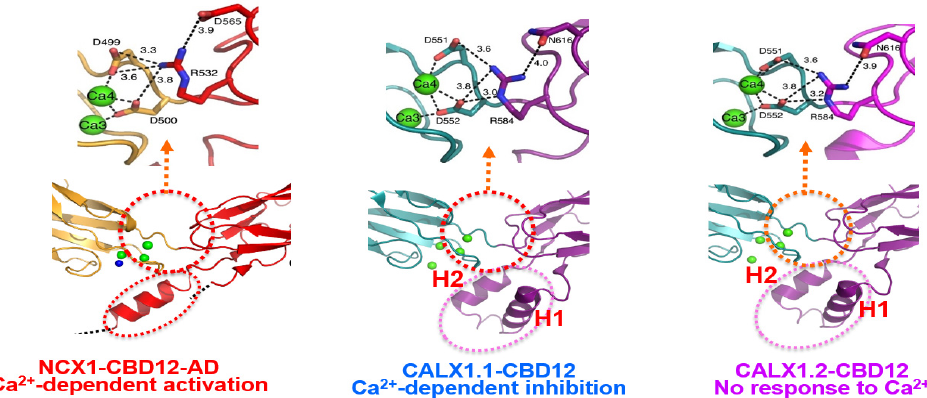
Figure 6. The interface structures of the two-domain CBD12 tandem in the NCX and CALX orthologs. Carton presentation of NCX1-CBD12-AD (PDB 3US9) and CALX1.1-CBD12 (PDB 3RB5) and CALX1.2 (PDB 3RB7) crystal structures depict highly conserved residues participating in the network of interdomain salt bridges. Green balls indicate the Ca 2+ binding sites at the interface of NCX1-CBD12-AD, CALX1.1-CBD12, and CALX1.2-CBD12. The blue ball in NCX1-CBD12 refers to the Ca 2+ binding site that cannot be resolved in the PDB 3US9 crystal structure, although the position of this Ca 2+ binding site is nearly identical to the Ca 2+ binding site of CALX1.1-CBD12 (PDB 3RB5) and CALX1.2 (PDB 3RB7) as revealed by these crystal structures. The Ca 2+ occlusion occurs at the high-affinity binding sites (Ca3-Ca4) of CBD1 in all three proteins (shown in the red-dotted cycle). Although the interdomain salt-bridge structures are highly conserved among NCX and CALX variants, a striking difference between the NCX and CALX variants occurs in the structural organization of the FG-loop α -helix at CBD2. More specifically, the CALX1.1-CBD12 and CALX1.2-CBD12 variants have a two- headed (H1 and H2) short-helix structure, which situates nearly perpendicularly to the β -sheet plane of CBD2. In contrast, the α -helix of NCX1-CBD12 is longer, while adopting a straight configuration. These structural disparities in the α -helix folding (in conjunction with variations in exon composition) can predefine the dynamic features of CBDs movements and, thus, the regulatory specificities of a given ortholog/isoform/splice variant. Thus, the structure-encoded dynamic distinctions of relevant structural elements may predefine (at least partially) the characteristic responses of full-size NCX and CALX variants to regulatory Ca 2+